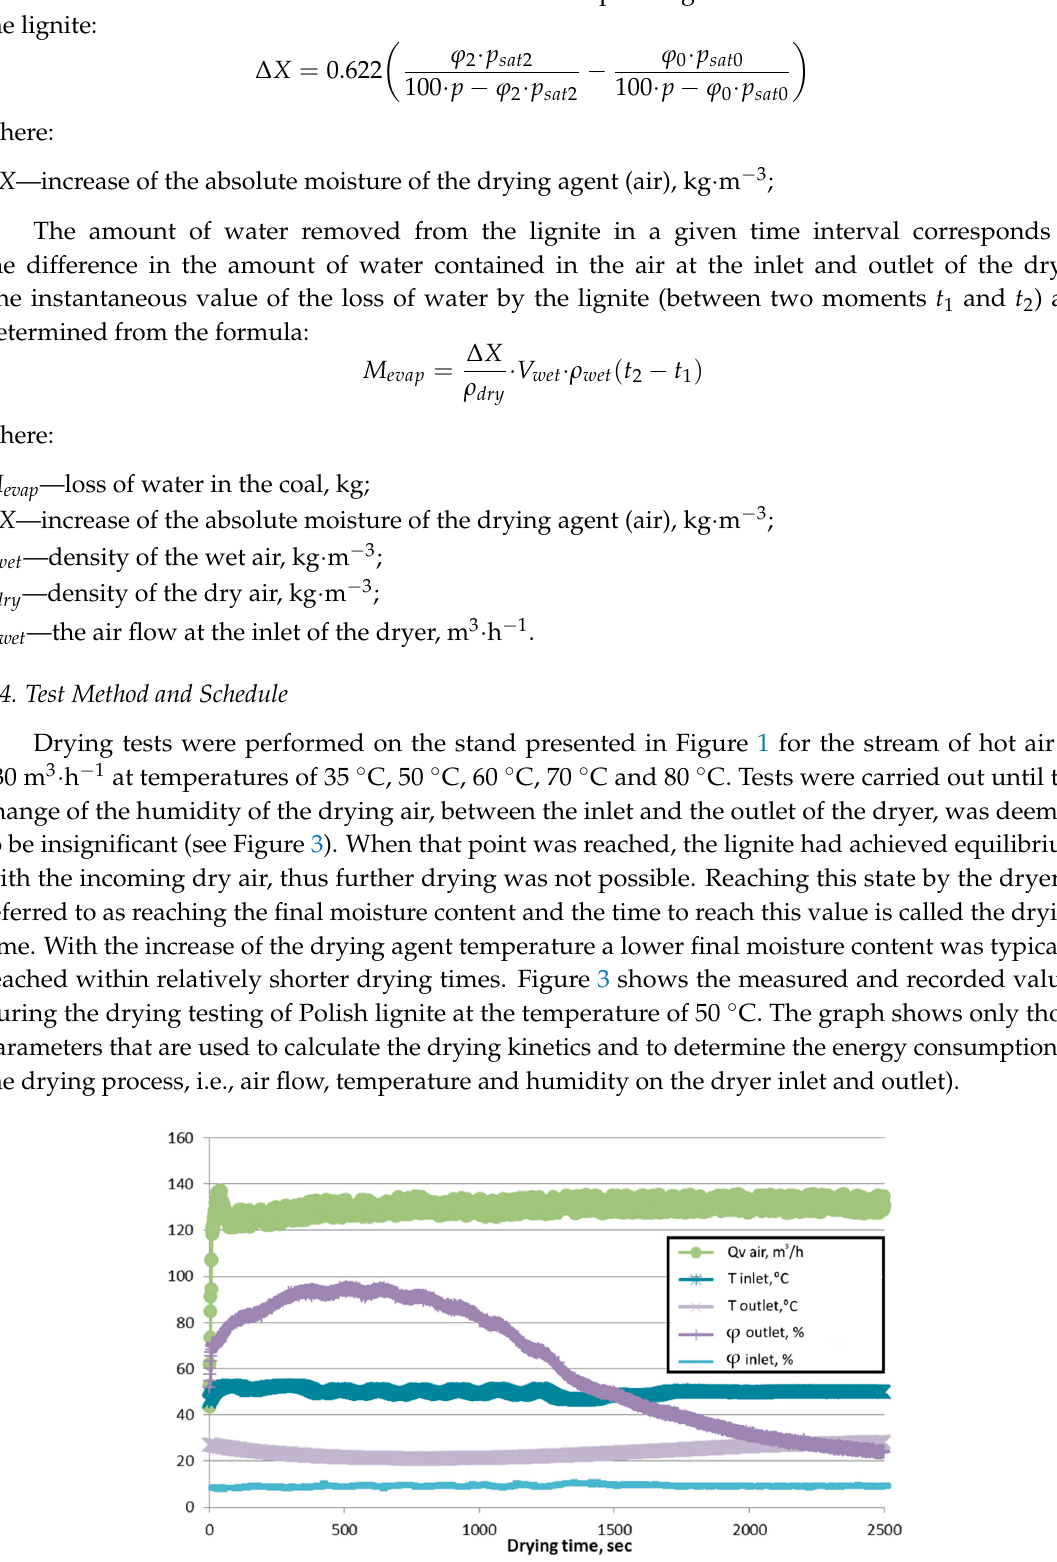
Figure 3. An example of the drying test for Polish lignite at the temperature of 50 °C.